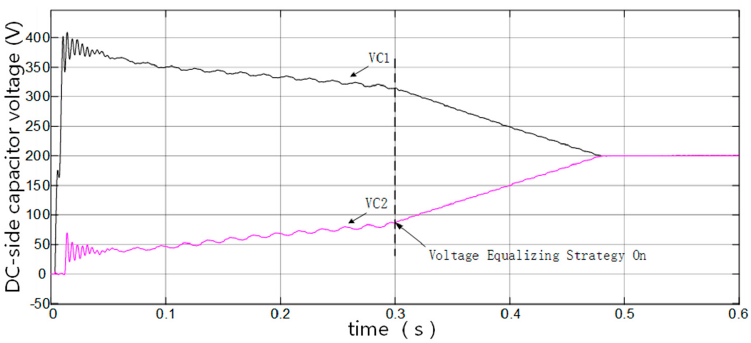
Figure 6. The DC capacitors voltages with and without equalization control.